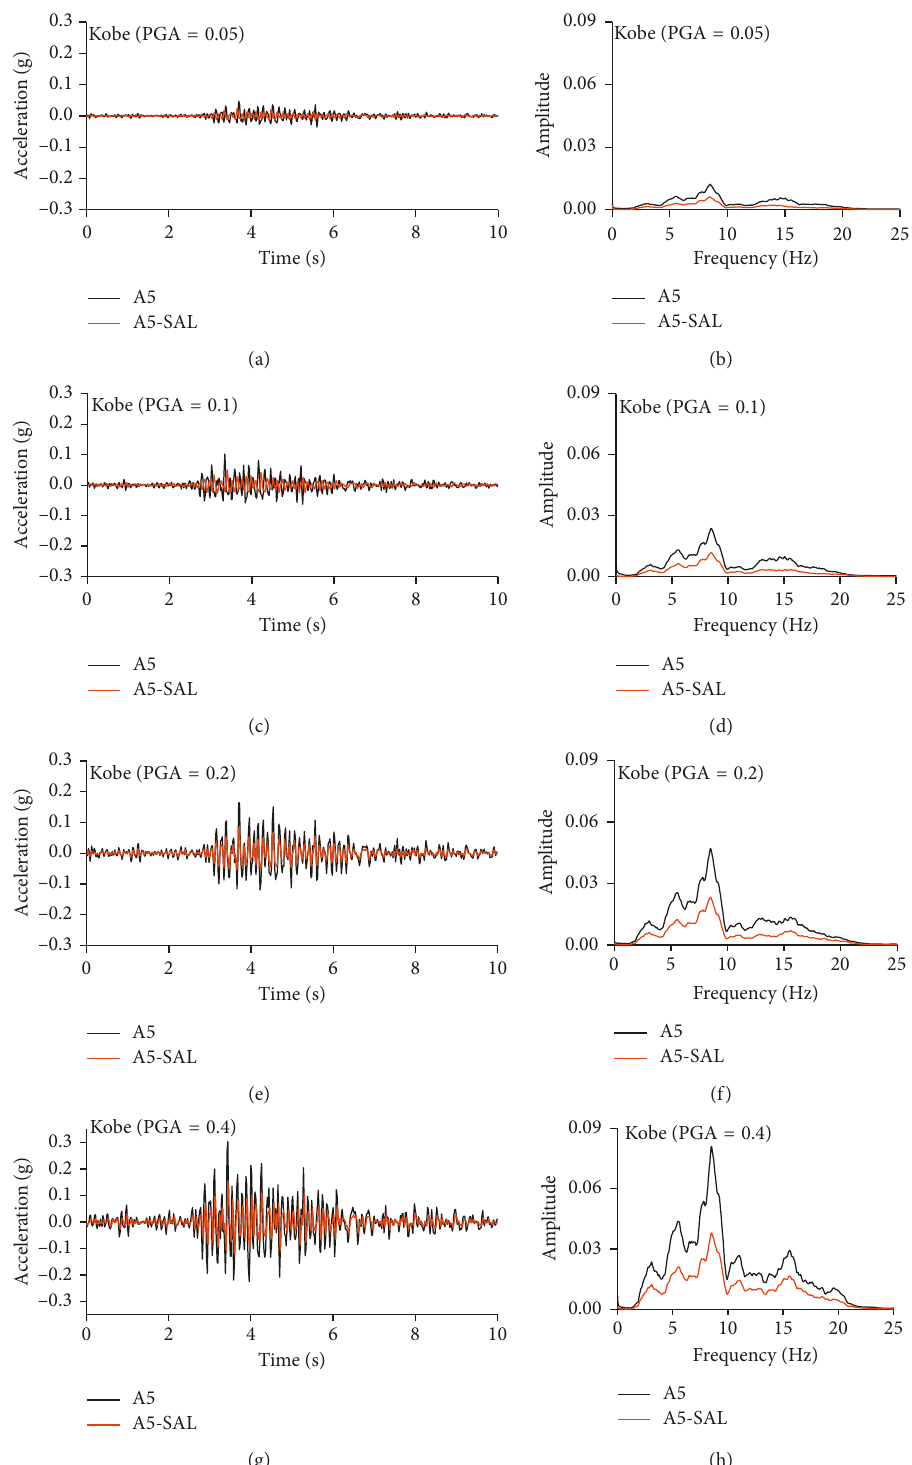
0.05g. (c) and (d) Peak acceleration (cid:31) (cid:31)